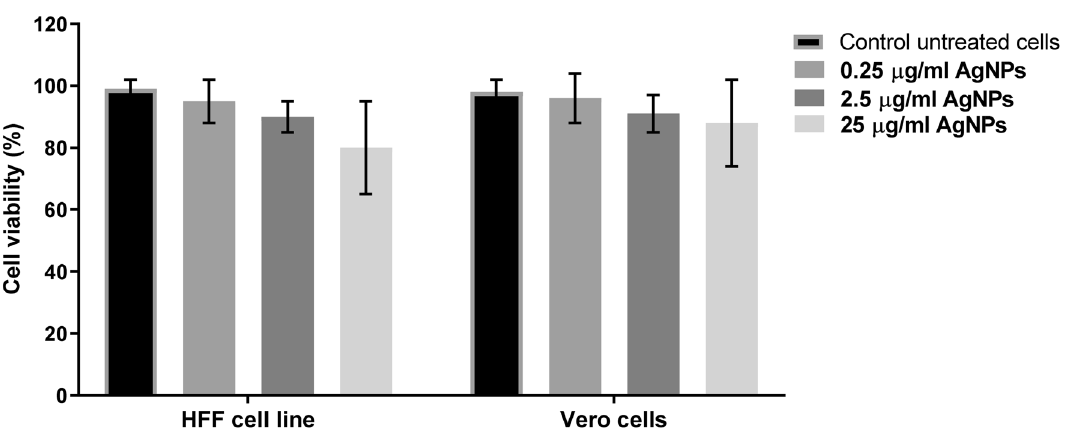
Figure 4. Analysis of in vitro Cytotoxicity of AgNPs. Percentage of the viable HFF and Vero cells treated with different concentrations of AgNPs. Results show the mean ± SEM of three independent